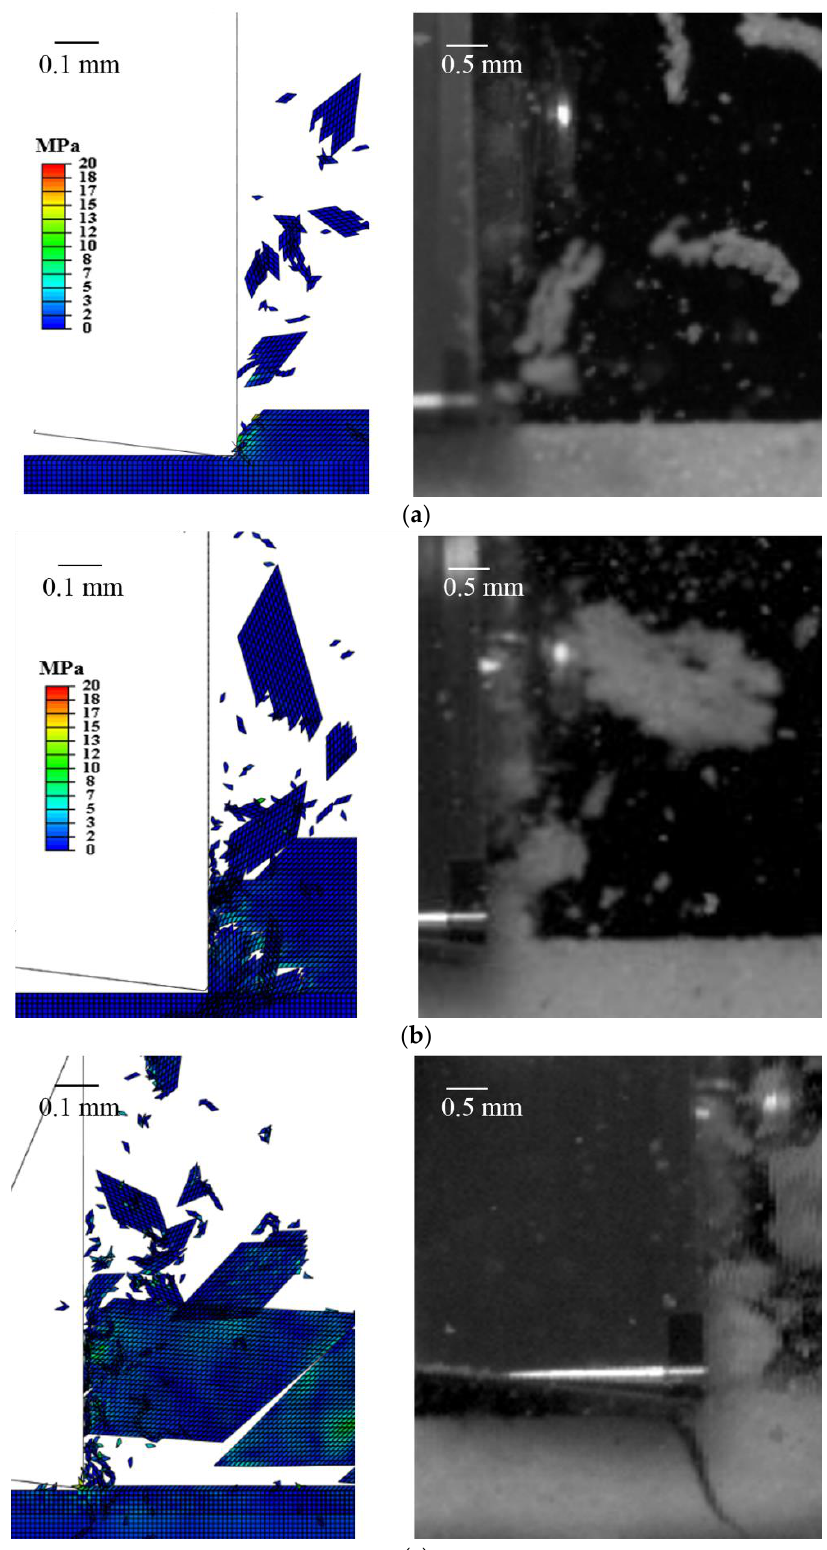
Figure 8. Simulated and experimentally measured chip formation of the 40 pcf with ( a ) DOC = 0.1 mm, ( b ) DOC = 0.3 mm, and ( c ) DOC = 0.3 mm at a later time step with a sudden crack propagation.